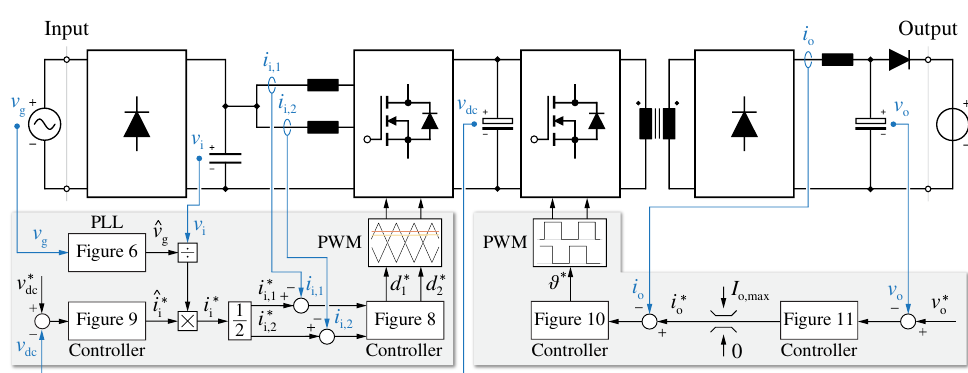
Figure 5. Simplified schematic of the OBC multi-loop control structure, including both con- verter stages.